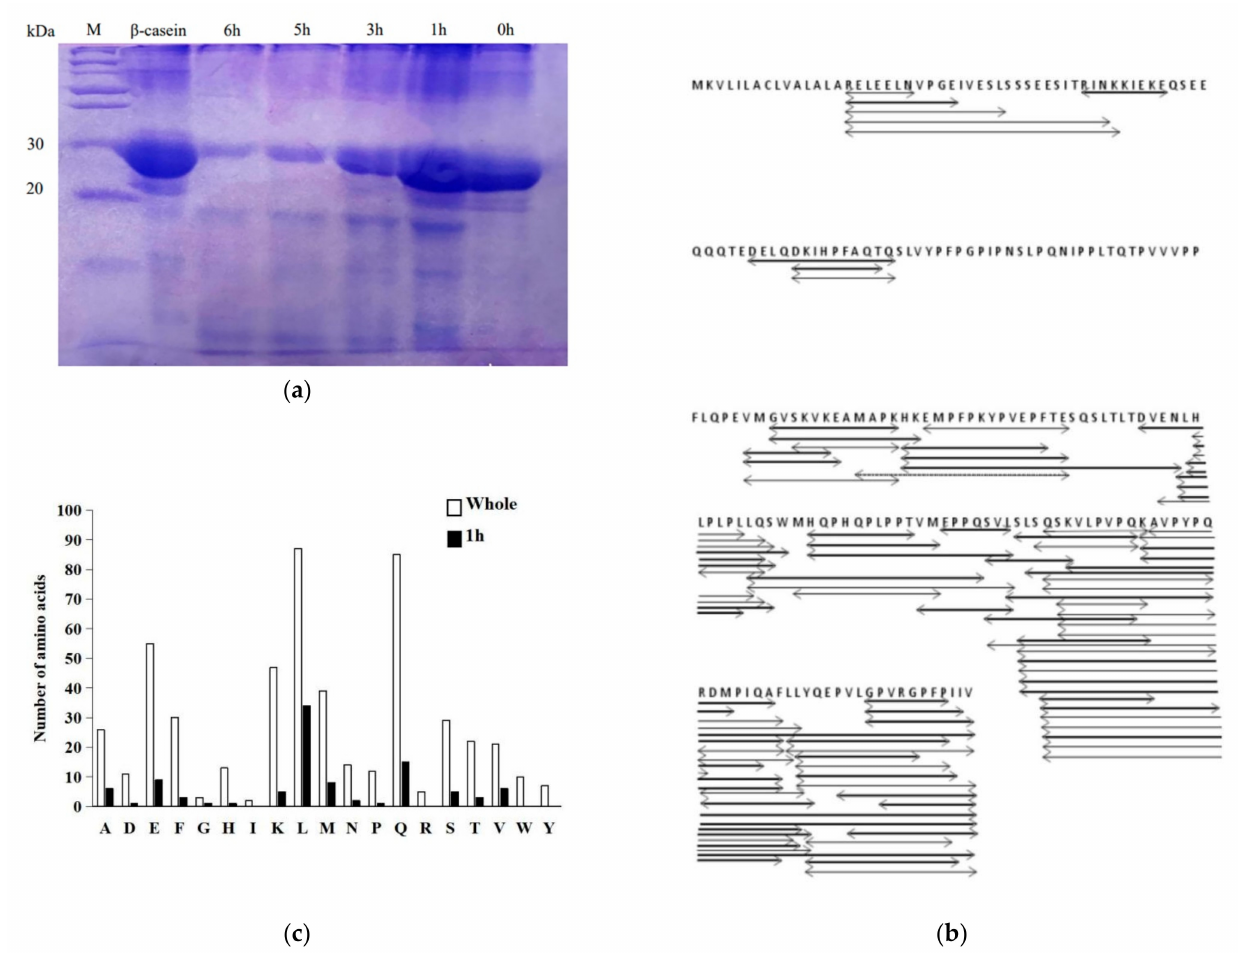
Figure 1. ( a ) shows the hydrolysis profile of β -casein caused by Lb. helveticus CICC 22171, ( b ) repre- sents the peptides contained after 1 h, ( c ) shows the numbers of the cleavage sites after 1 h and for the whole